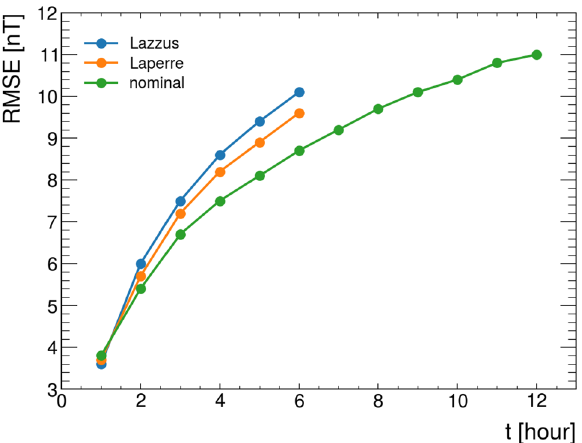
Figure 4. Comparison between the RMSE as a function of the forecast horizon obtained with the nominal neural network presented in this work and two state-of-the-art solutions.